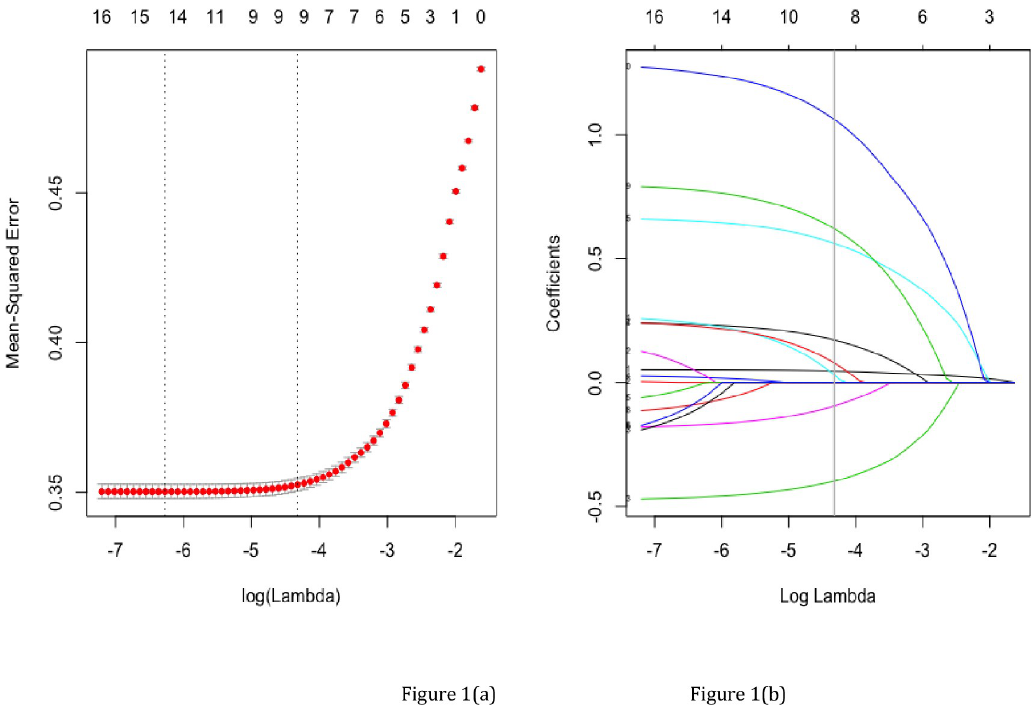
Fig 1. Texture feature selection using the least absolute shrinkage and selection operator (LASSO) binary logistic regression model. (a) Optimization parameters(Lambda) of lasso model were selected by 10 times cross-validation. The Mean-Squared Error was plotted versus log(Lambda). Dotted vertical lines were drawn at the optimal values by using the minimum criteria and the 1 standard error of the minimum criteria (the 1-SE criteria). Minimum criteria refer to the one among all λ values to get the mean value of the minimum target parameter. 1-SE criteria refer to the λ value of the simplest model in a variance range of minimum criteria. (b) LASSO coefficient profiles of the 18 features. A coefficient profile plot was produced against the log Lambda) sequence. Vertical line was drawn at the value selected using 10 times cross-validation, where optimal lambda resulted in 9 features with nonzero coefficients.